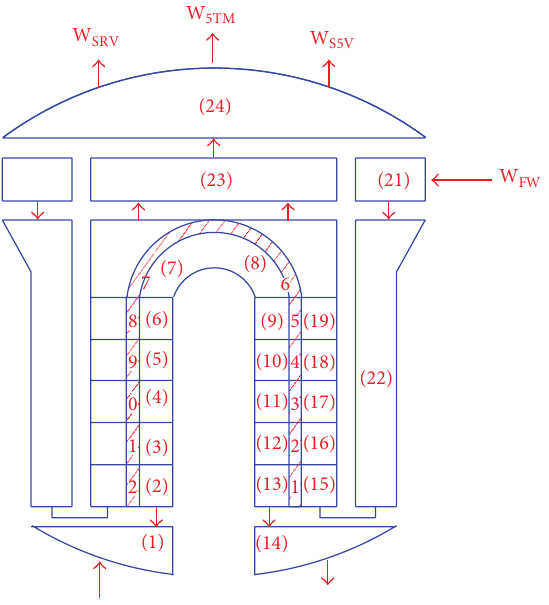
Figure 10: MASAP nodalization diagram of